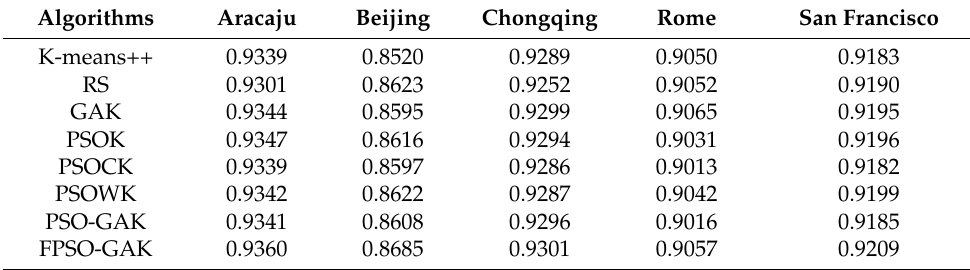
Figure 8. The SSE convergence curve for the searching optimal initial clustering centers stage of taxi GPS dataset from San Francisco (USA). Table 5. Average Silhouette coefficient of 8 algorithms trained 20 times in 5 GPS data sets.